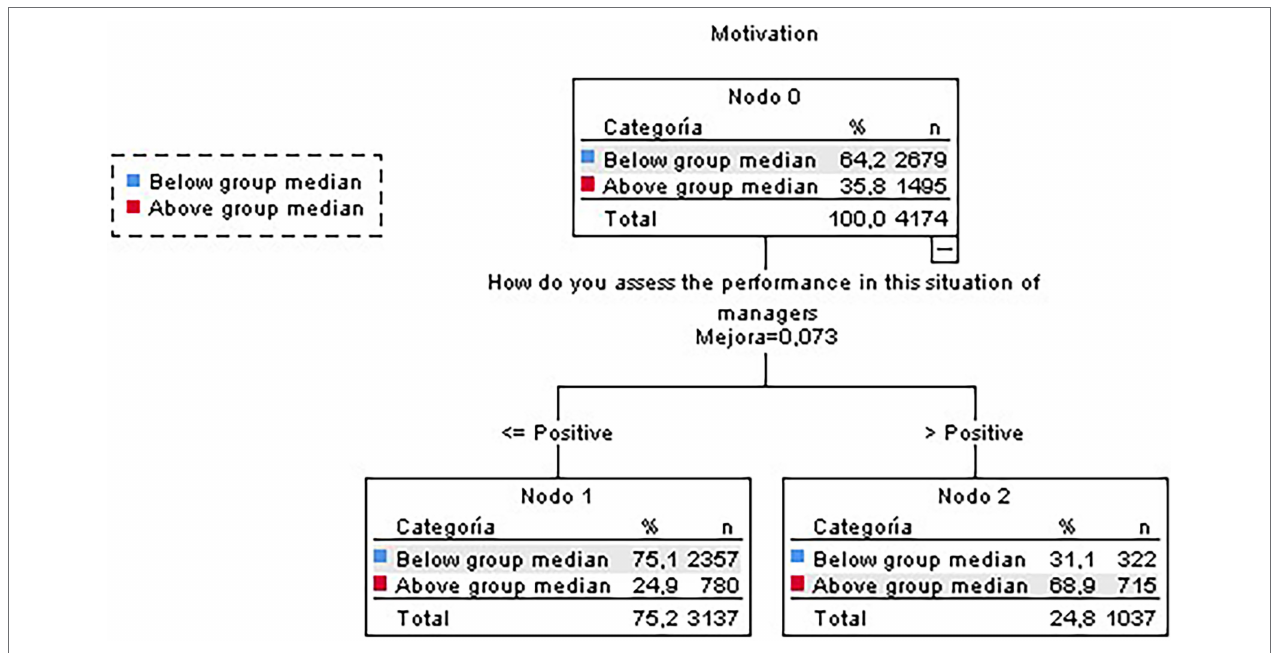
FIGURE 3 | Classification tree for motivation (non-teleworkers